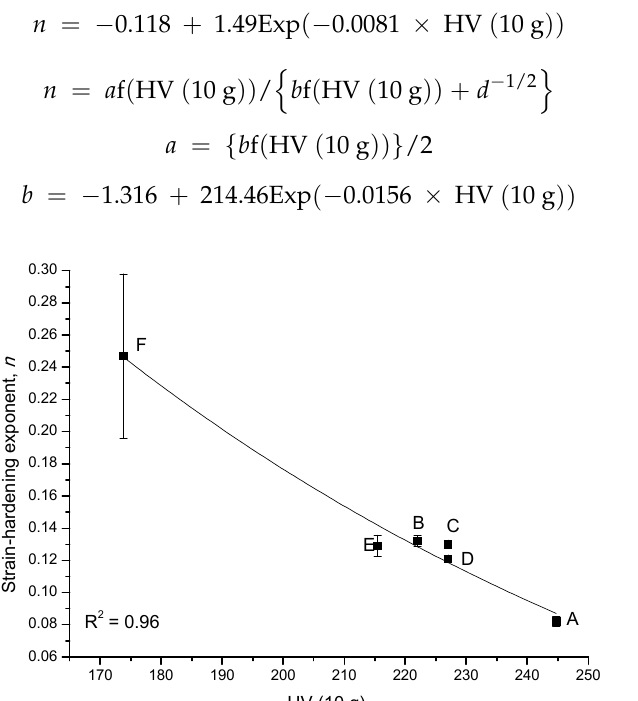
Figure 4. Relationship between experimental values of n and the average microhardness HV (10 g) of 100 ferritic grains. Where: A = straight stretch, B = Intrados , C = Extrados , D = Extrados tempered at 600 °C, E = Extrados tempered at 650 °C and F = straight stretch normalized at 900 °C.